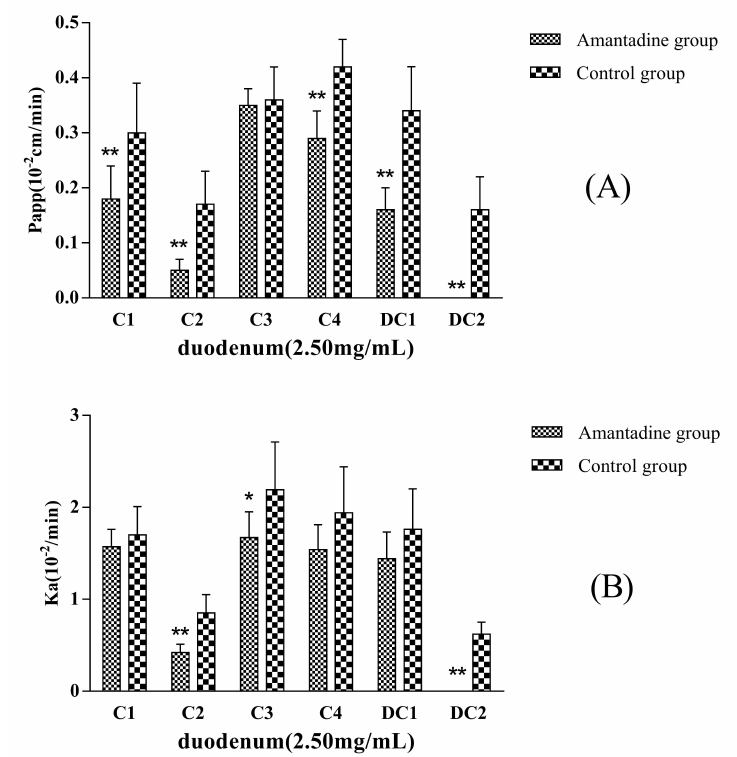
Figure 4. P app ( A ) and K a ( B ) of the six analytes in duodenum obtained after in situ single-pass perfusion of MDQ-TS (2.5 mg/mL) with or without amantadine. The rat duodenum (~10 cm) was used to evaluate the intestinal permeability of MDQ-TS. Data was expressed as mean ± SD of five independent experiments each group. * p < 0.05 versus non-amantadine group; ** p < 0.01 versus non-amantadine